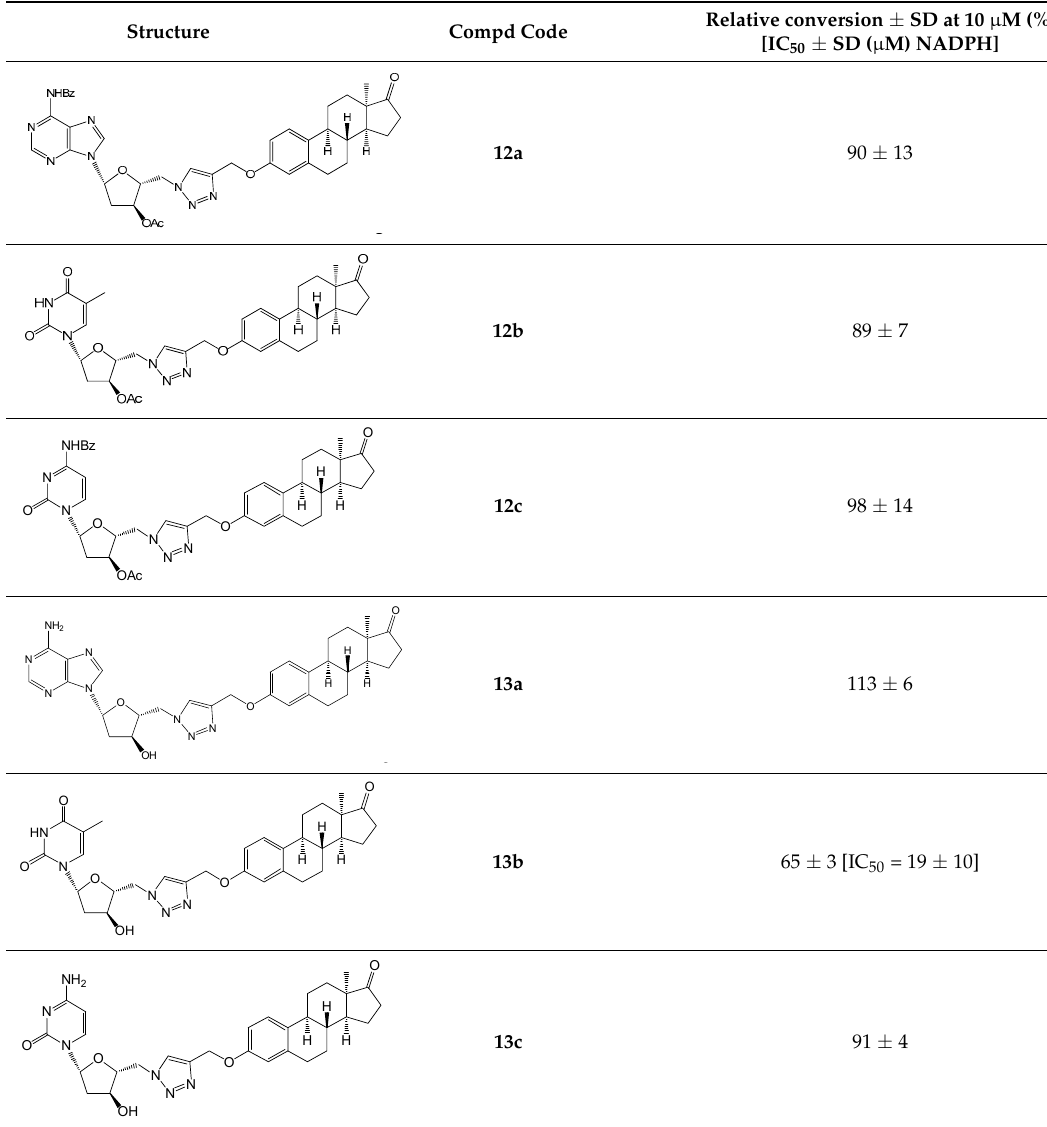
Table 3. Inhibition results on 17 β -HSD1. Relative conversions (control incubation with no inhibition is Molecules 2016 , 21 , 1212 100%) measured in the presence of 10 µ M of the compound tested. IC 50 : The inhibitor concentration Table 3 Inhibition results on 17 β -HSD1. Relative conversions (control incubation with no inhibition Molecules 2016 , 21 , 1212 9 of 17 Table 3 Inhibition results on 17 β -HSD1. Relative conversions (control incubation with no inhibition Molecules 2016 , 21 , 1212 that decreases the enzyme activity to 50%. SD: standard deviation (for relative conversion n = 3). is 100%) measured in the presence of 10 μ M of the compound tested. IC 50 : The inhibitor concentration Table 3 Inhibition results on 17 β -HSD1. Relative conversions (control incubation with no inhibition Molecules 2016 , 21 , 1212 9 of 17 is 100%) measured in the presence of 10 μ M of the compound tested. IC 50 : The inhibitor concentration that decreases the enzyme activity to 50%. SD: standard deviation (for relative conversion n = 3). Table 3 Inhibition results on 17 β -HSD1. Relative conversions (control incubation with no inhibition is 100%) measured in the presence of 10 μ M of the compound tested. IC 50 : The inhibitor concentration Table 3 Inhibition results on 17 β -HSD1. Relative conversions (control incubation with no inhibition that decreases the enzyme activity to 50%. SD: standard deviation (for relative conversion n = 3). is 100%) measured in the presence of 10 μ M of the compound tested. IC 50 : The inhibitor concentration that decreases the enzyme activity to 50%. SD: standard deviation (for relative conversion n = 3). Table 3 Inhibition results on 17 β -HSD1. Relative conversions (control incubation with no inhibition is 100%) measured in the presence of 10 μ M of the compound tested. IC 50 : The inhibitor concentration that decreases the enzyme activity to 50%. SD: standard deviation (for relative conversion n = 3). is 100%) measured in the presence of 10 μ M of the compound tested. IC 50 : The inhibitor concentration that decreases the enzyme activity to 50%. SD: standard deviation (for relative conversion n = 3). that decreases the enzyme activity to 50%. SD: standard deviation (for relative conversion n =